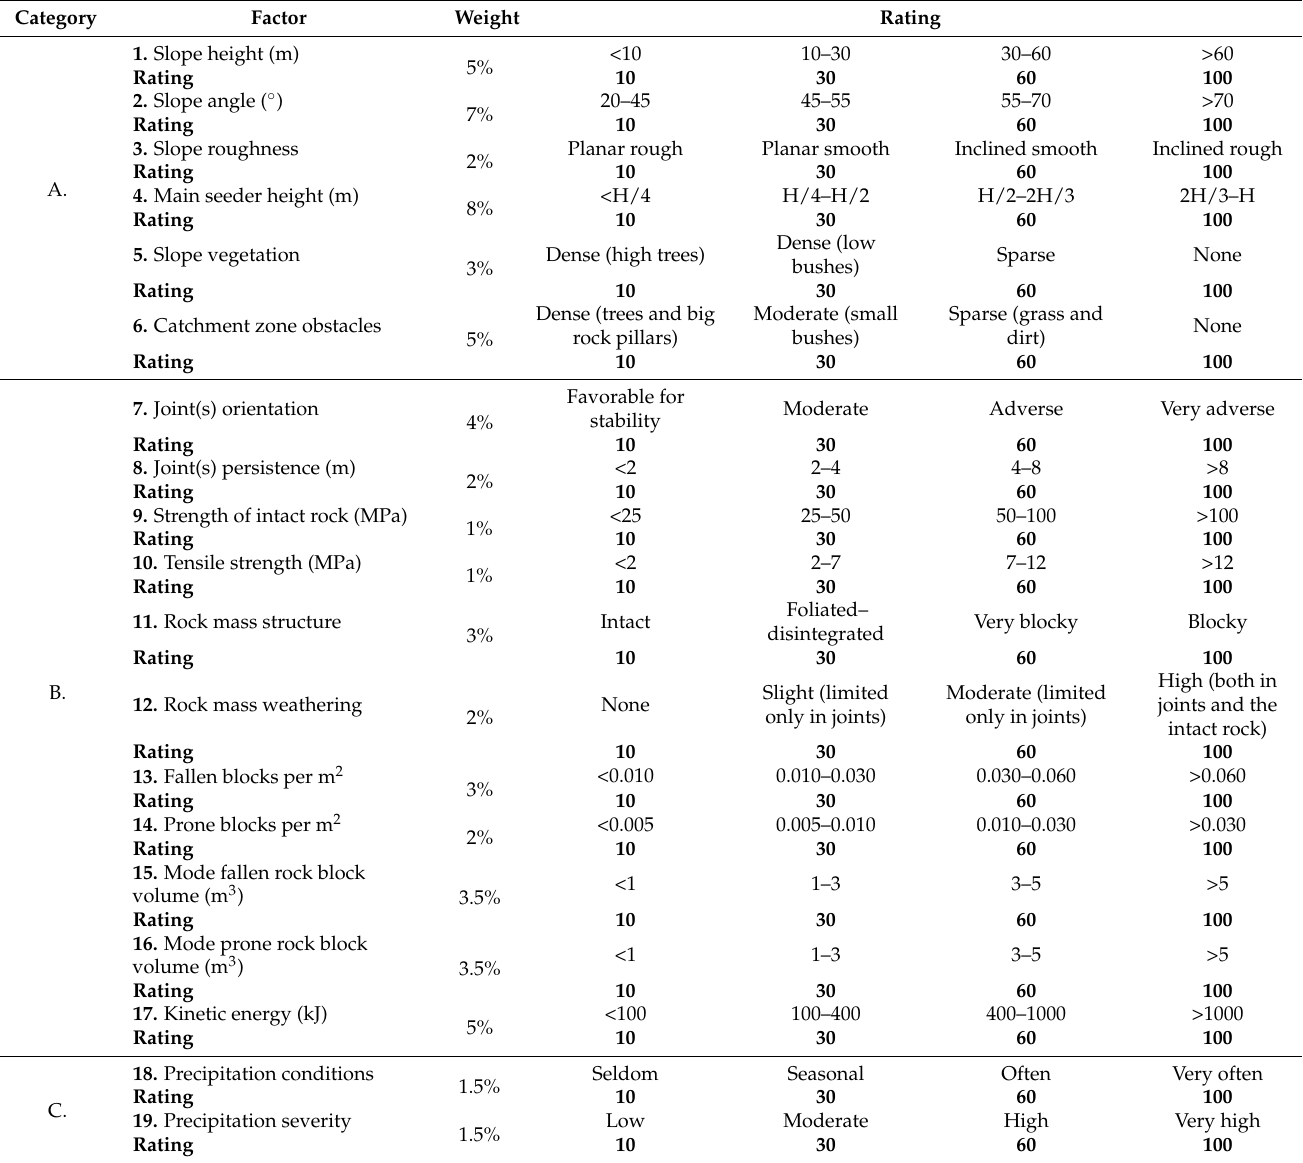
Table 7. The parameters and their rating for the proposed Rockfall Hazard and Risk Rating System. Category Factor Weight